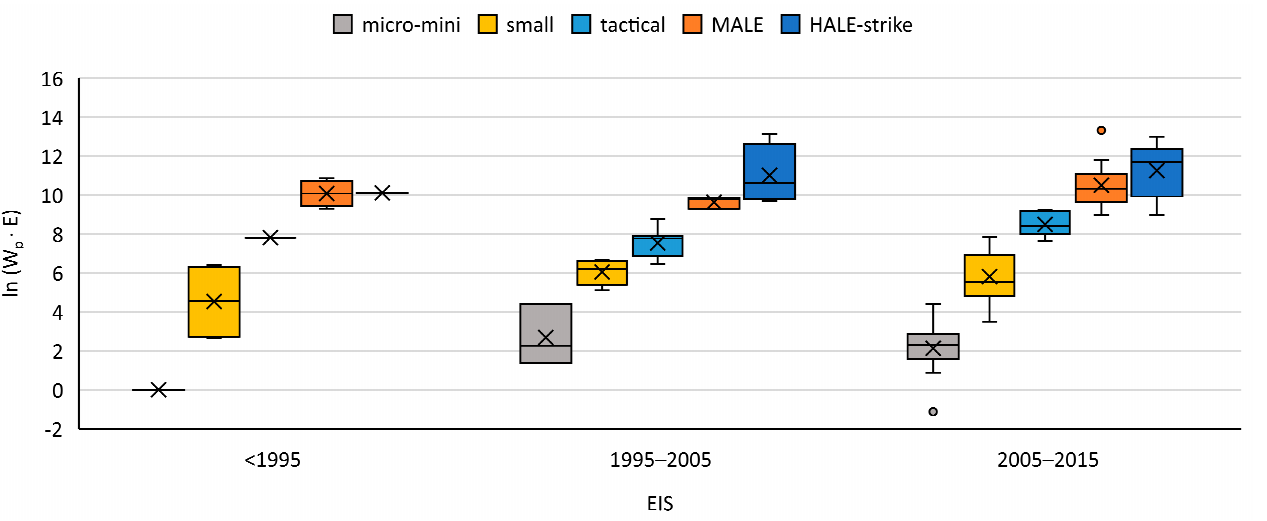
Figure 26. W p · E product EIS progression per NATO category.